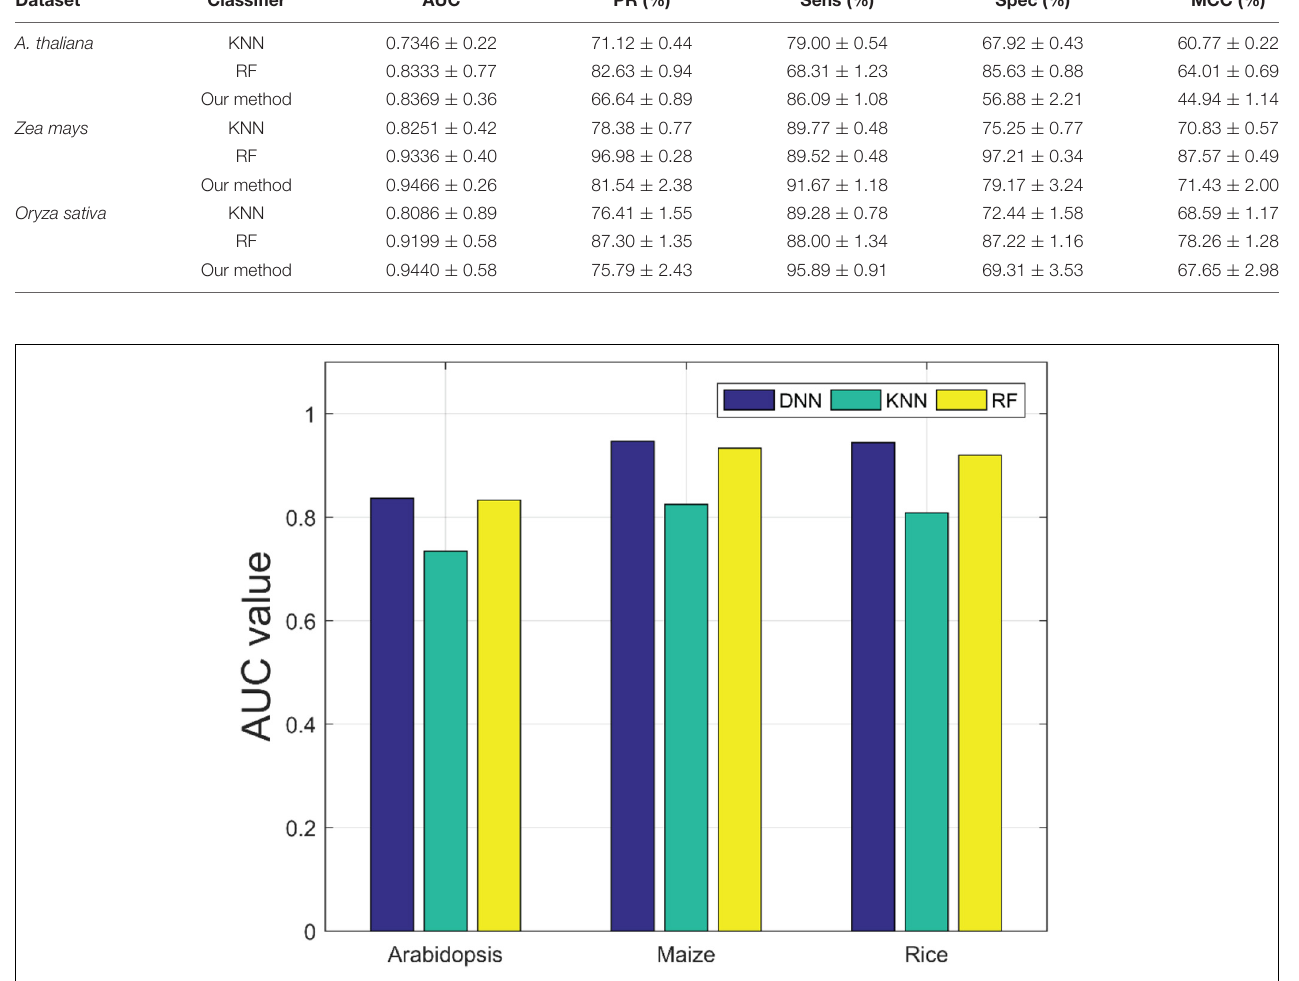
FIGURE 5 | Comparison results of AUC values obtained by deep neural network (DNN), K-nearest neighbor (KNN), and random forest (RF) classifiers on the three plant PPI datasets.